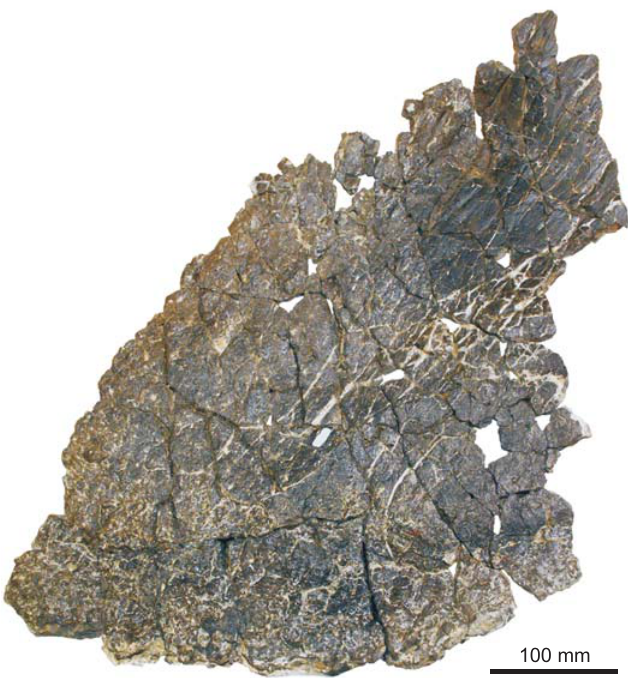
Fig. 19. Dorsal plate of stegosaur GPDM 178, near Giffen, Cascade County,